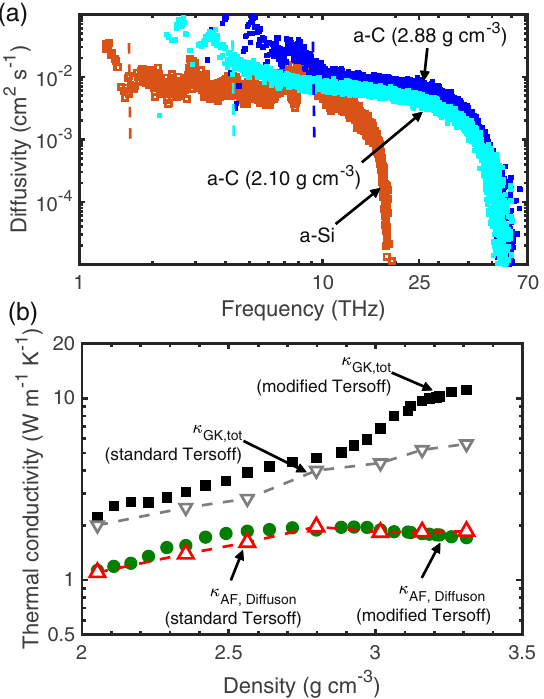
Fig. 4 Diffuson contribution to thermal conductivity in amor- phous carbon. a Characteristic mode diffusivity calculations from the Allen and Feldman theory for our amorphous carbon structures with high (2.88 g cm − 3 ) and low (2.1 g cm − 3 ) mass densities. For comparison, the diffusivities for an amorphous silicon domain described by the Stillinger-Weber potential is also included. The dashed lines represent cutoff frequencies for propagating modes below which the diffusivities are relatively higher. b Thermal conductivity based on the Allen and Feldman theory for diffusons as a function of mass densities calculated for our amorphous carbon domains described by the standard (red hollow triangles) and modi fi ed (green solid circles) Tersoff potentials. For compar- ison, we also plot the total thermal conductivities predicted from our molecular dynamics simulations based on the Green-Kubo approach. (calculated from additional simulations) 42 . The sharp decrease in the diffusivities at higher frequencies is indicative of the localized nature of the modes (locons), which do not contribute to the total thermal conductivity directly 43 . For the low-frequency modes (as denoted by the cutoff frequencies signifying the onset of the Debye scaling), diffusivities are relatively larger, which is consistent with their propagating nature. The intermediate frequencies with relatively constant diffusivities are categorized as diffusons for which the contribution to the total thermal conductivity can be calculated by utilizing Eq. (2). Note, the diffusivities of the delocalized modes (diffusons) are higher if the spatial overlap between the eigenvectors are increased as well as if the energetic overlap between the modes are closer to each other. As such, these criterion lead to relatively lower diffusivities for the structures with low densities (<2.5 g cm − 3 ), which are comparable to the diffusivities of modes in our Stillinger-Weber amorphous silicon domain (see Fig. 4a). Therefore, Eq. (2) predicts similar diffuson contributions to the thermal conductivity in the two different structures (~1.1 W m − 1 K − 1 ). Figure 4b shows the contribution from the diffusons to the total thermal conductivity for the different amorphous carbon struc- tures described by both the standard and the modi fi ed Tersoff potentials. For comparison, we also include the total GK-predicted thermal conductivities for our amorphous carbon structures.